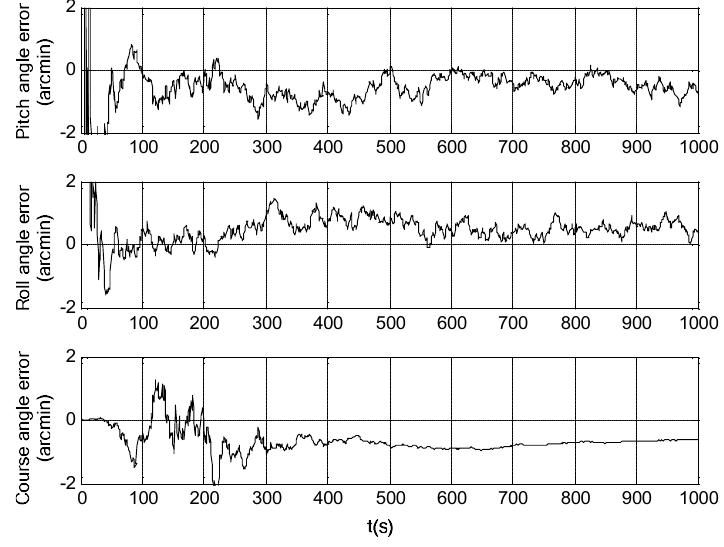
Figure 9. Attitude error of SINS/SRS/SS integrated navigation system.